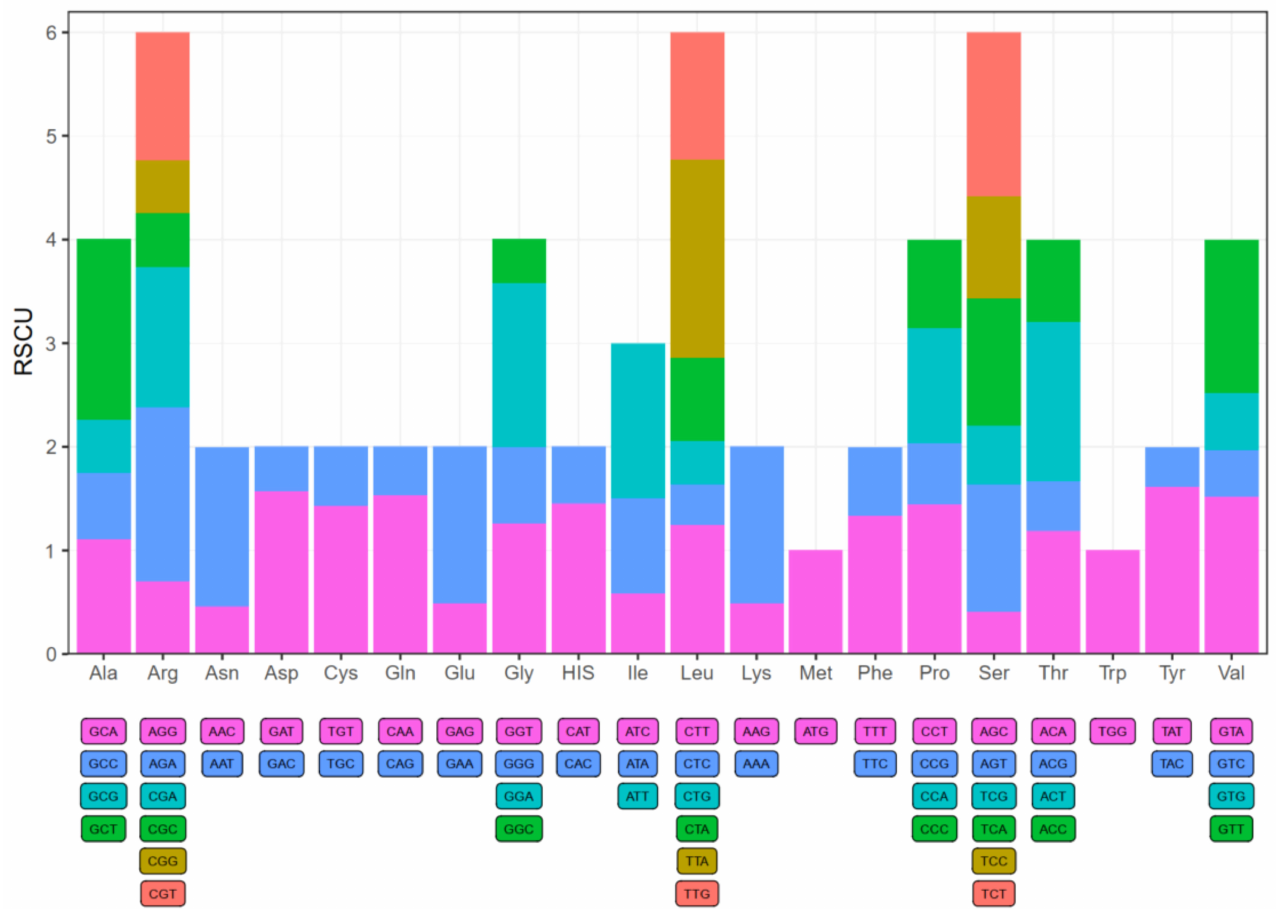
Figure 3. Codon content of 20 amino acids and stop codons in all protein-coding genes of N. lappaceum chloroplast genome. The colour of the histogram corresponds to the colour of